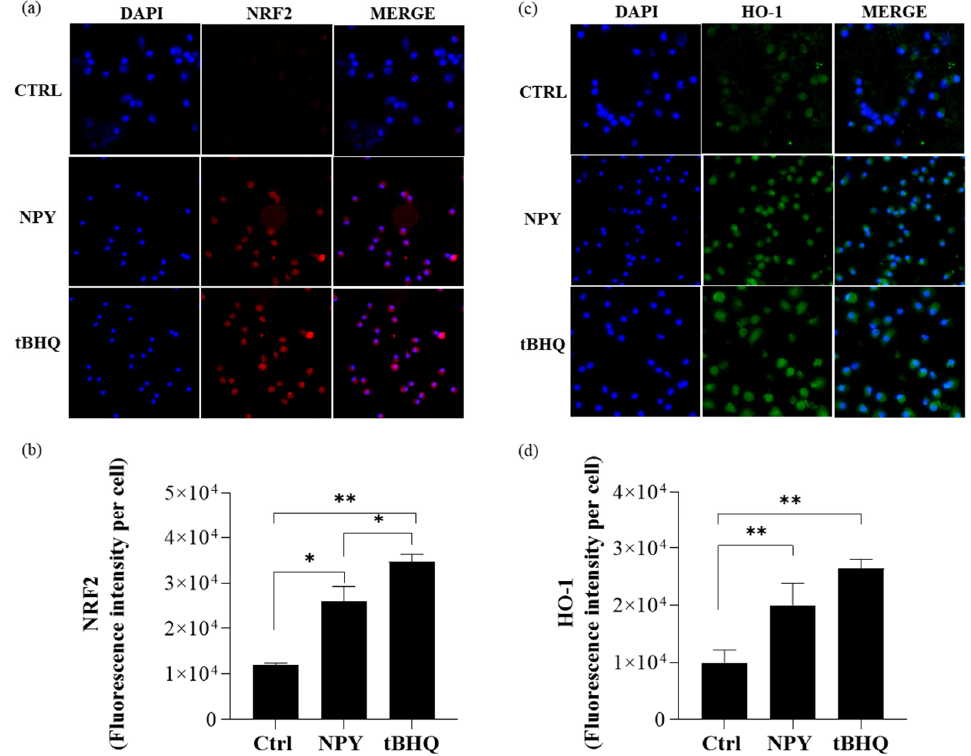
Figure 8. Immunofluorescent analysis of NRF-2 and HO-1 expression in M0 macrophages treated with 10 − 8 M NPY and 10 µ M tertbutylhydroquinone (t-BHQ). ( a ) Representative immunofluorescent staining of NRF2 in M0 macrophages treated with NPY or tertbutylhydroquinone (t-BHQ) for 8 h. ( b ) Quantification of the intensity of the fluorescence signal for NRF2-positive cells. ( c ) Representative immunofluorescent staining of HO-1 in M0 macrophages treated with NPY or tertbutylhydroquinone (t-BHQ) for 24 h. ( d ) Quantification of the intensity of the fluorescence signal for HO-1-positive cells. Immunofluorescence analysis was performed using the ImageJ software. DAPI was used to counterstain the nuclei. Data are presented as the mean ± SD for each group ( N = 3). For ( b , d ), significance was determined by one-way ANOVA followed by Tukey’s post hoc analysis; *: p < 0.05, **: p < 0.01. The upright microscope Nikon Eclipse Ni-U with 60× magnification was used to capture micrographs.